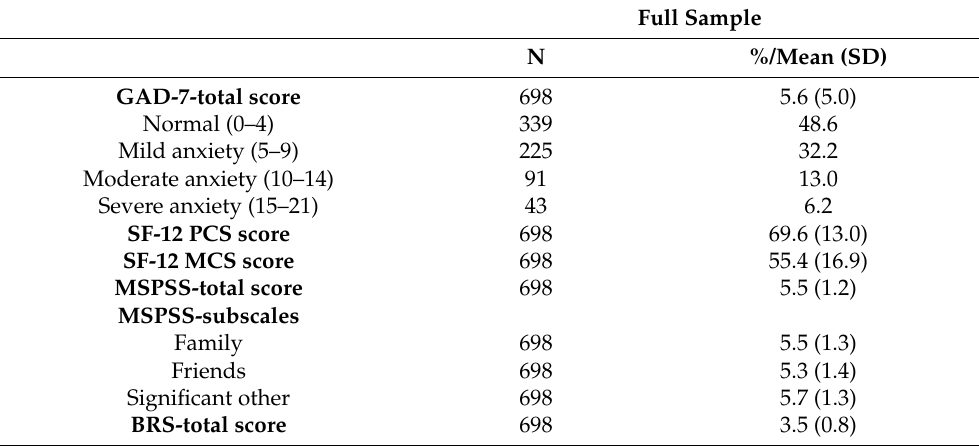
Table 3. Parental anxiety, social support and resilience scores during the lockdown (N = 698).